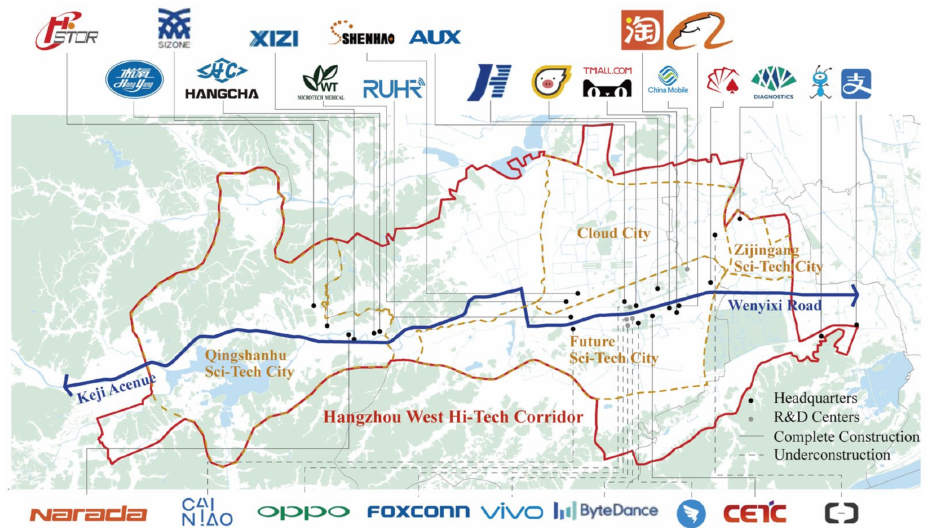
Figure 2. Spatial structure of the Corridor and the distribution of corporate headquarters and corporate R&D centers. Logos of some world-renowned corporate headquarters and corporate R&D centers are